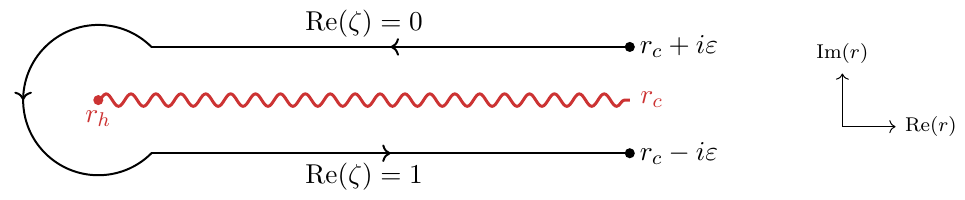
Figure 3 . The complex r plane with the locations of the two boundaries and the horizon marked. The grSK contour is a codimension-1 surface in this plane (drawn at (cid:12)xed v ). The direction of the contour is as indicated counter-clockwise encircling the branch point at the